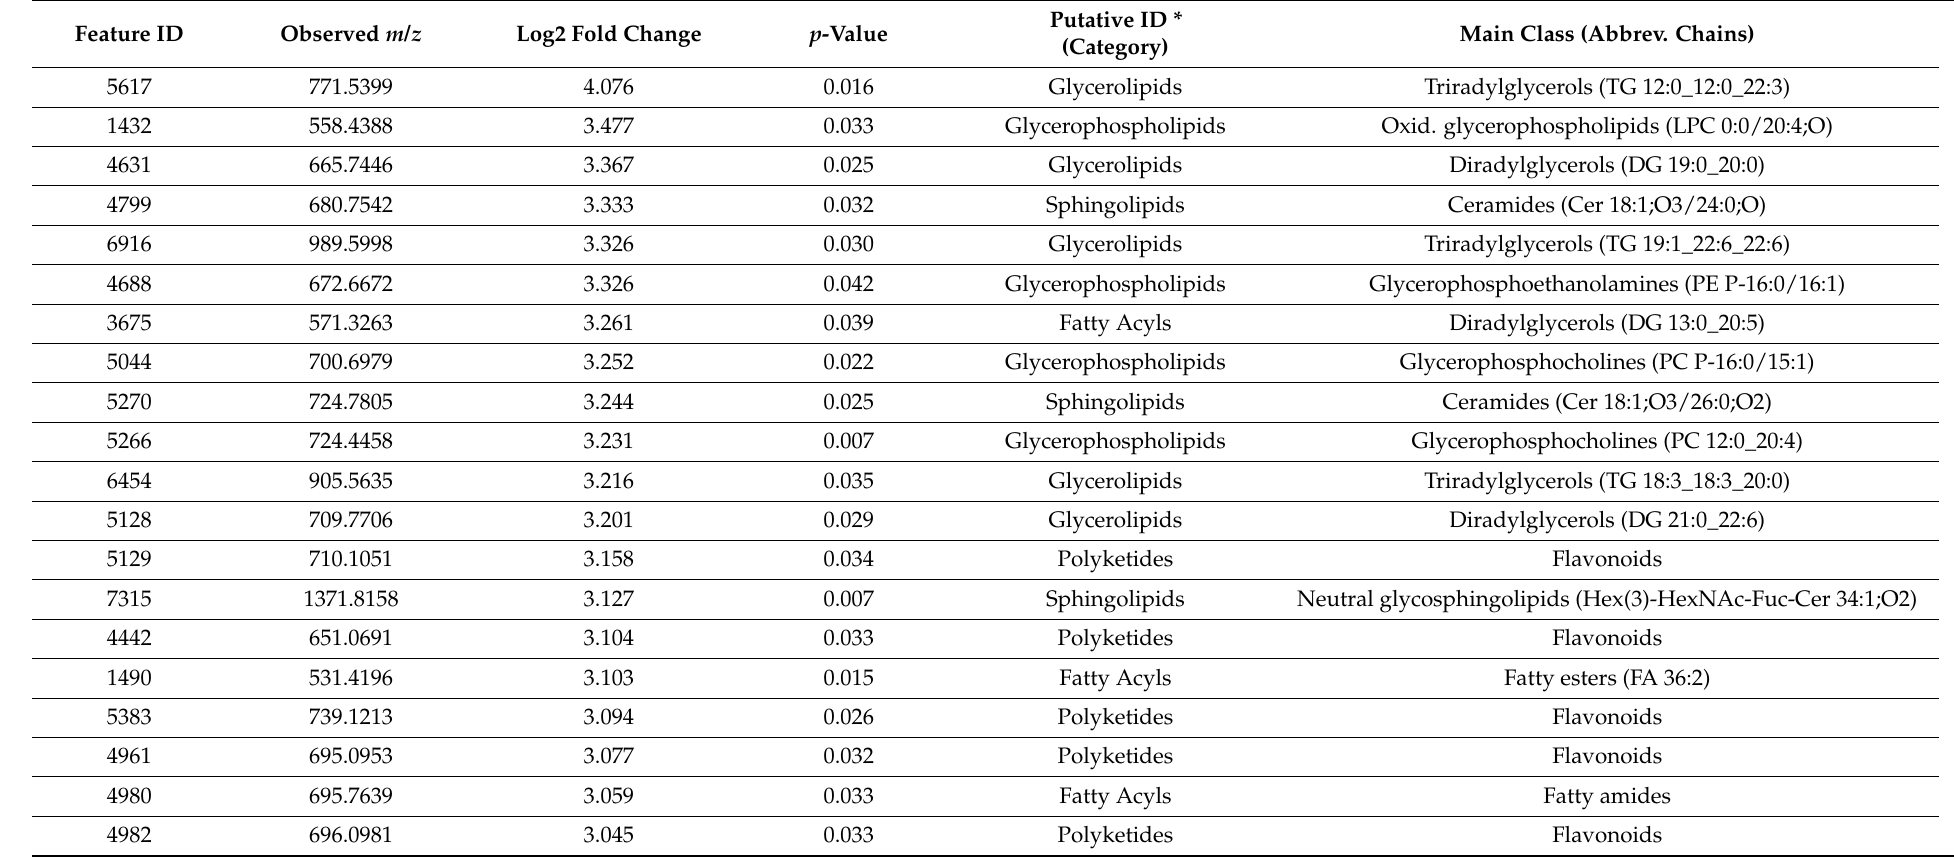
Table 2. Putative LMSD ID of lipids with the highest fold change in the MetS